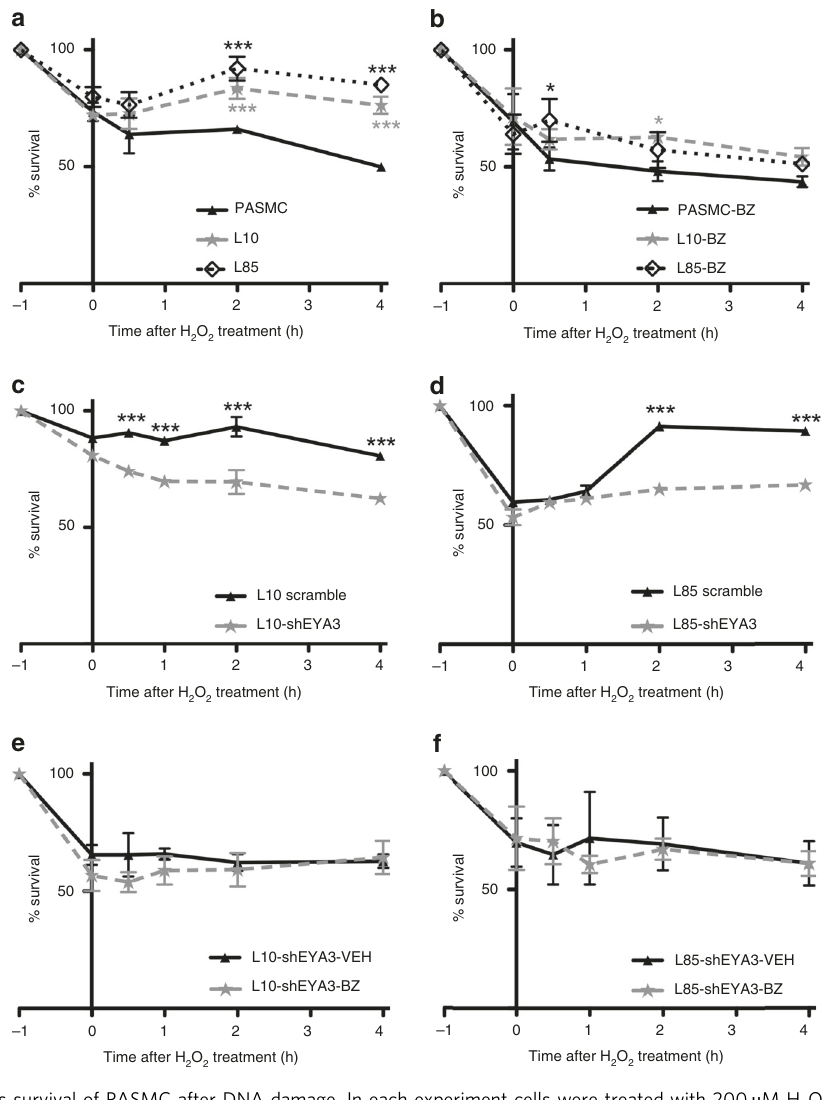
Fig. 2 EYA3 PTP promotes survival of PASMC after DNA damage. In each experiment cells were treated with 200 μ M H 2 O 2 for 1 h. H 2 O 2 was then withdrawn and the cells allowed to recover in normal culture medium. The percentage of viable cells (relative to untreated controls) were monitored using the WST-8 cell viability assay and are plotted versus time ( x -axis). − 1 h indicates the start of H 2 O 2 treatment. H 2 O 2 was withdrawn at 0 h. Each experiment was conducted at least three times. Representative data shown as the mean ± SD; statistical signi fi cance was determined using two-way ANOVA and Bonferroni ’ s post-test, *** P < 0.001, * P < 0.05. a Recovery from H 2 O 2 treatment of control PASMC and PAH-PASMC (L10 and L85)